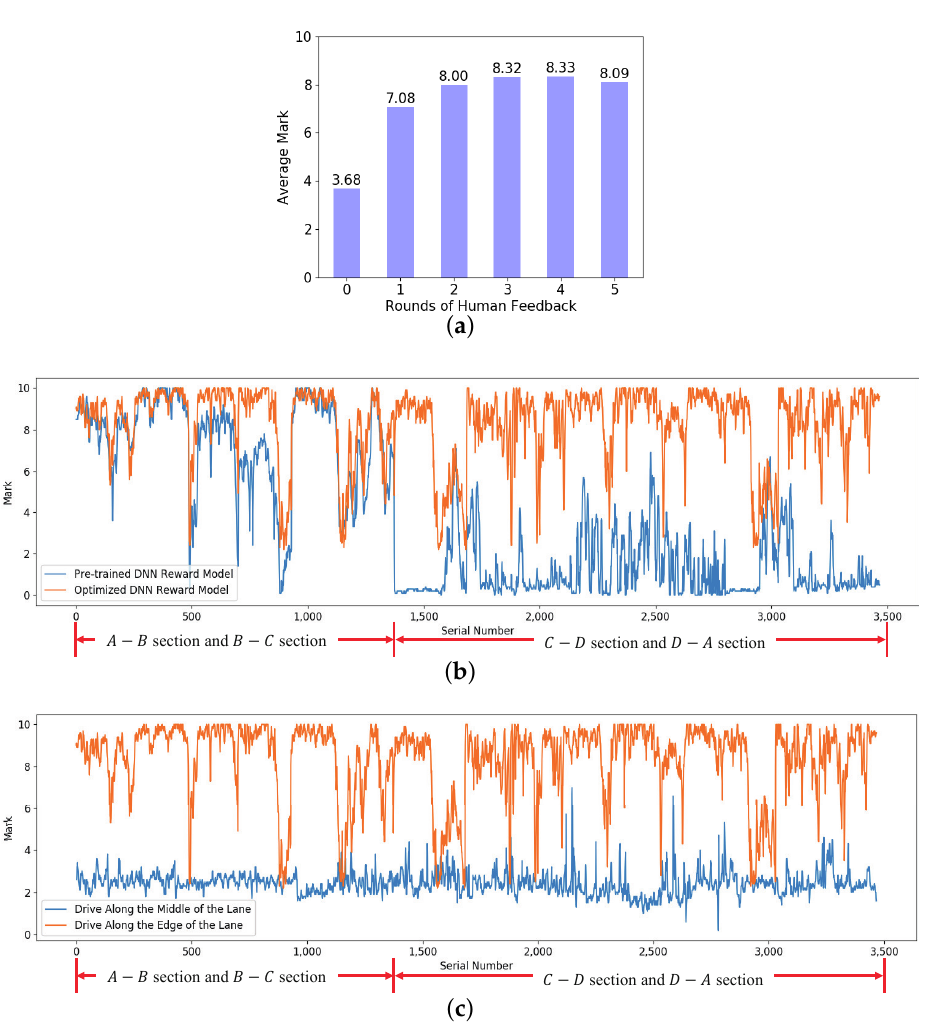
Figure 13. The performance of the DNN reward model in the real